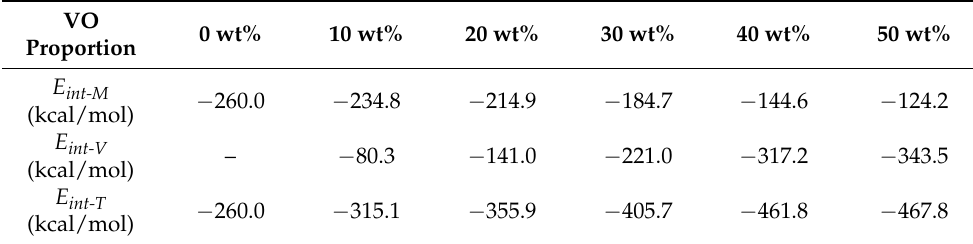
Table 13. Interaction energy between mixed oil and water molecules with 3 wt% of water content.